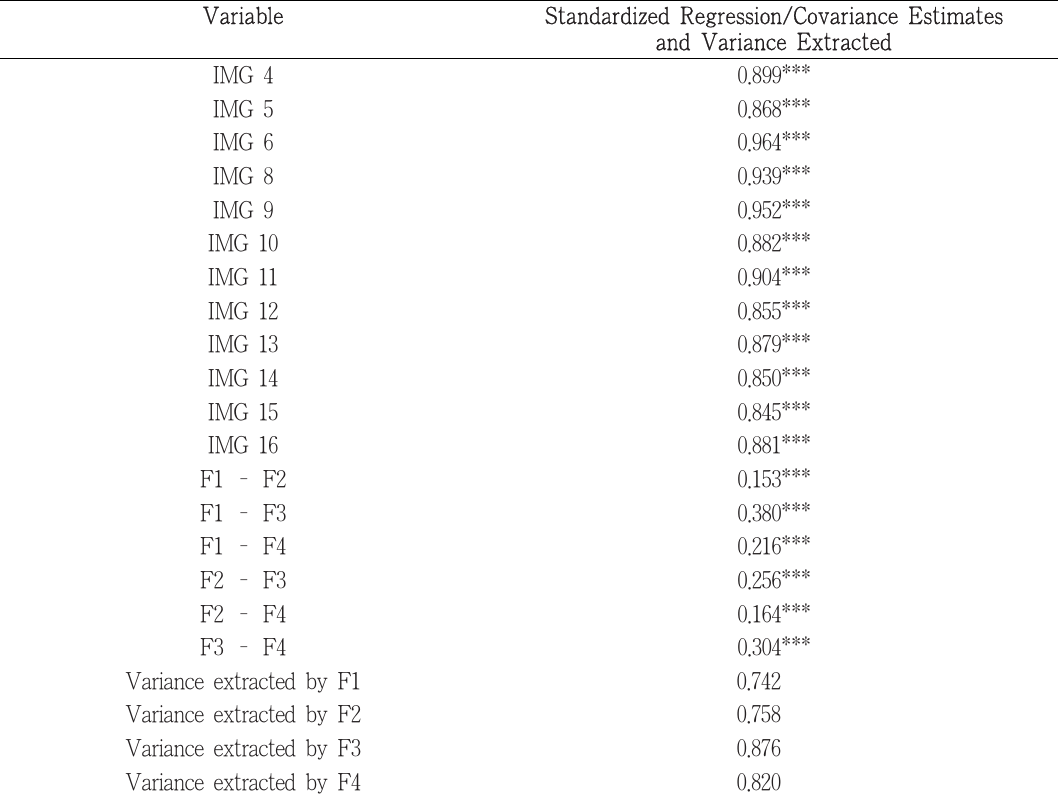
<Table 2> Results of Baseline Confirmatory Factor Analysis: Regression Coeffiecient and